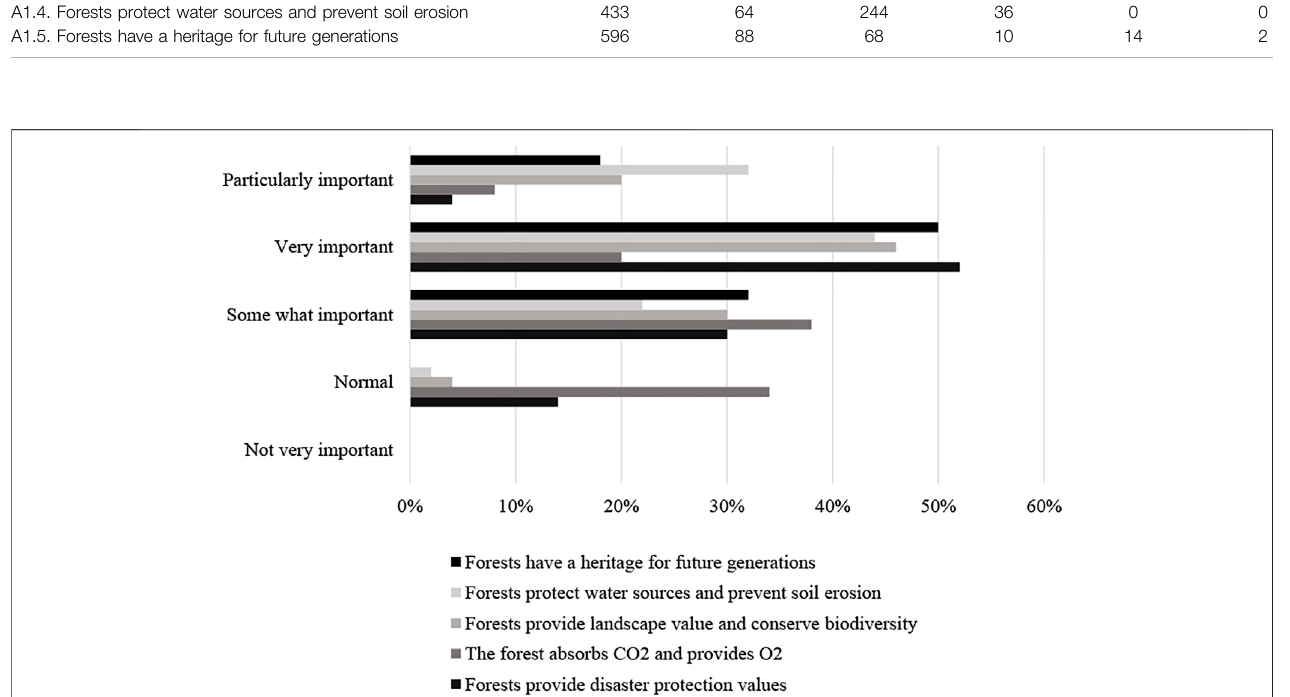
FIGURE 3 | The percentage of people rating the importance of preserving forest resources